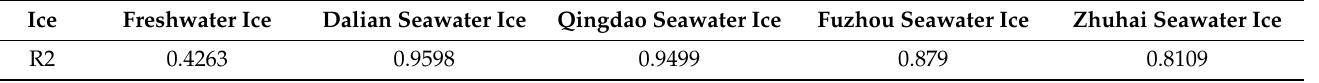
Table 4. The goodness of fitting curve of tensile strength test. (How close the values in the table are to 1 determines the curve fit accuracy. The seawater test results are well fitted while the freshwater test results are not).